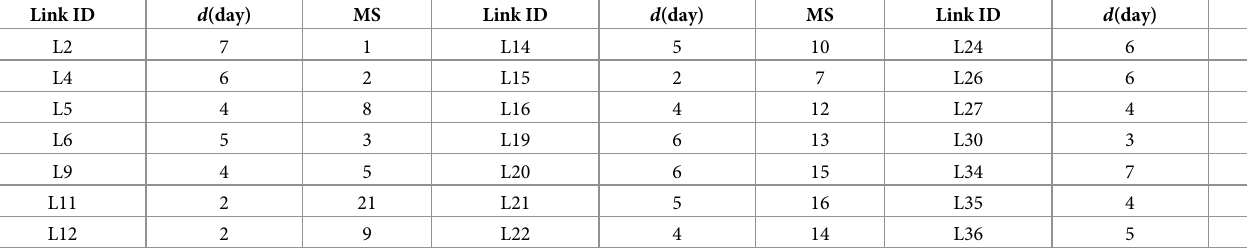
Table 3. Duration and maintenance sequence (MS) of the 21 links to be maintained.